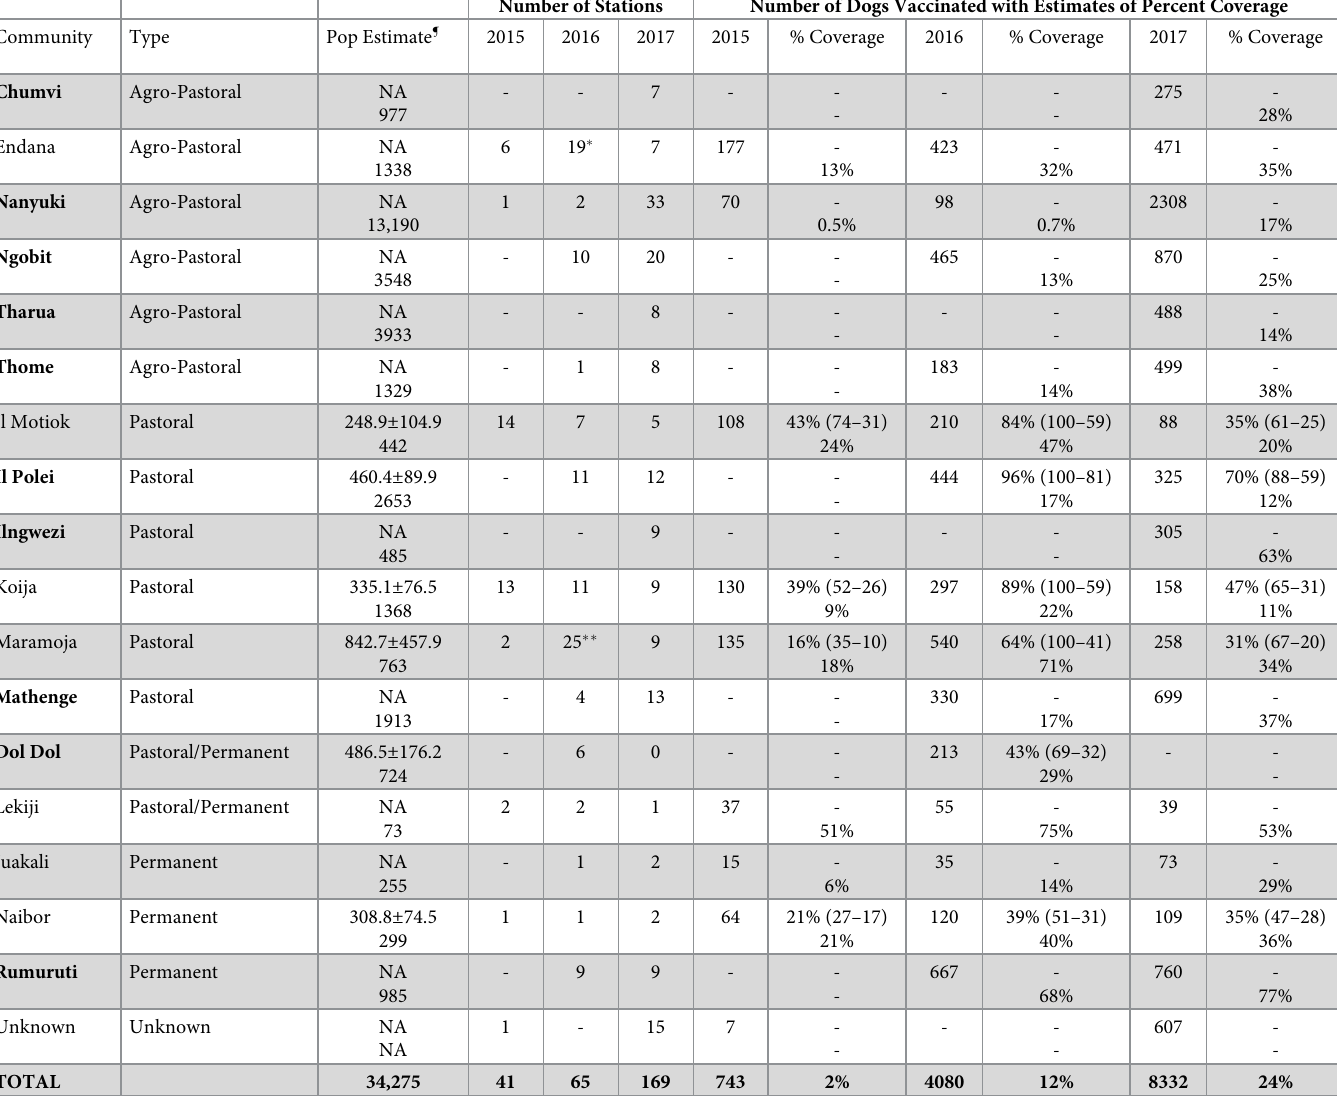
Table 1. Community by community summaries for domestic dog vaccinations against rabies during the Laikipia Rabies Vaccination Campaign, 2015–2017, Laiki- pia County, Kenya. Number of Stations Number of Dogs Vaccinated with Estimates of Percent